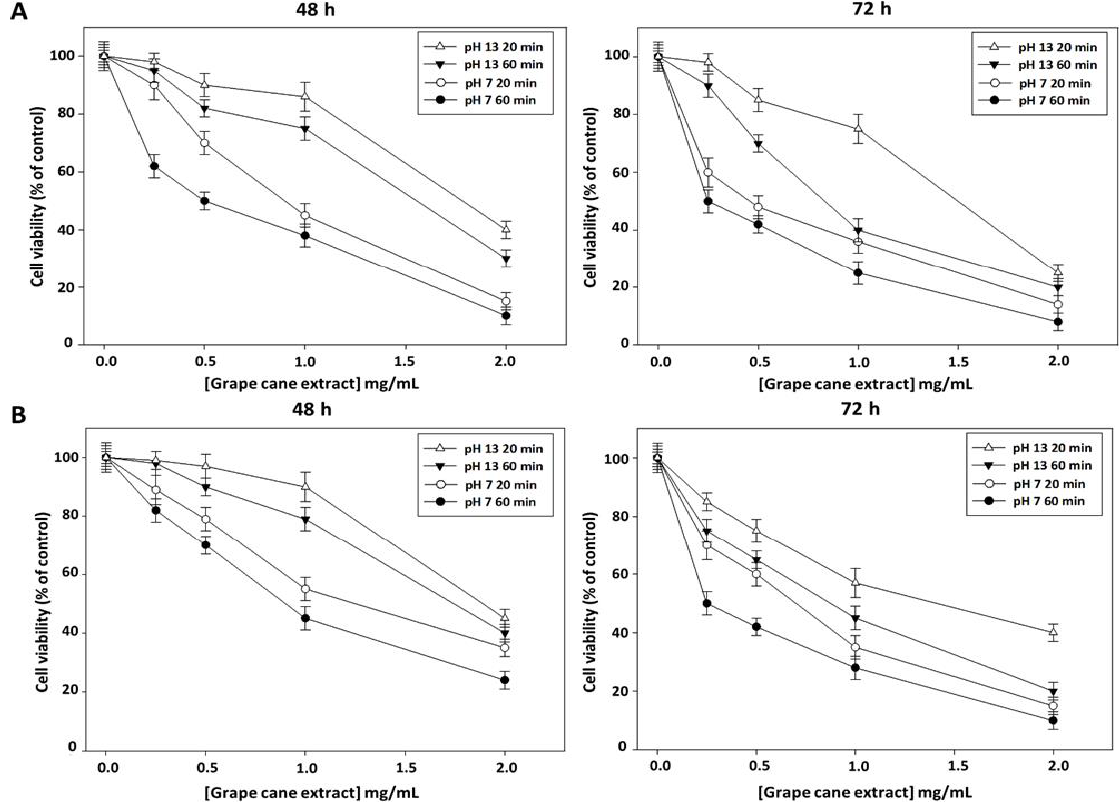
Figure 3. Effect of “Greco” grape cane extracts prepared at different pHs and extraction times on cell viability of Cal-33 and JHU-SCC-011 cell lines. Cal-33 ( A ) and JHU-SCC-011 ( B ) cells were treated for 48 and 72 h with increasing amounts of grape cane extracts (from 0.25 mg/mL to 2.0 mg/mL) obtained at different pHs (7 and 13) and extraction times (20 and 60 min), then cell viability was assessed by MTT assay. Results are presented as a percentage of the control cells. Error bars depict the standard deviation ± SD of quadruplicated measurements and are representative of three separate experiments.